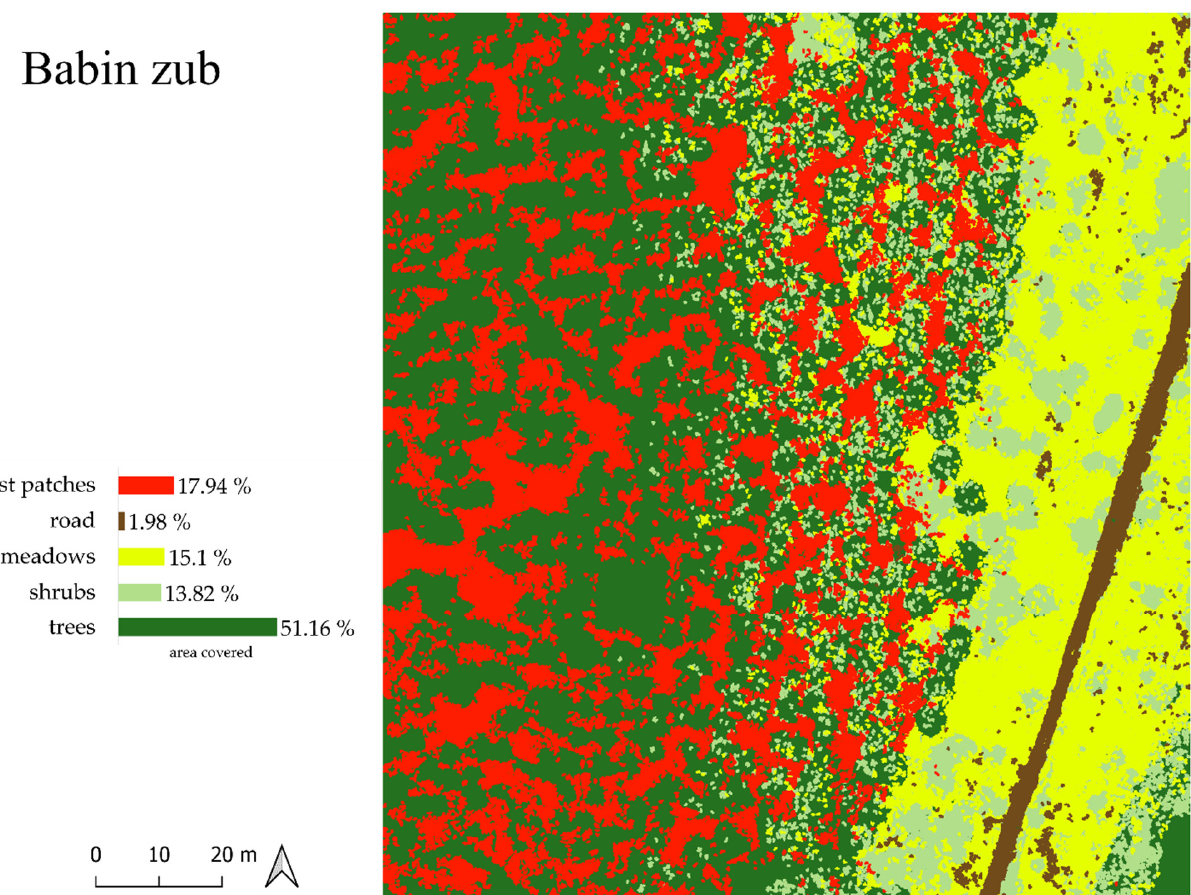
Figure 7. Map of the land cover classification for the study site Babin zub obtained by RF classification algorithm.